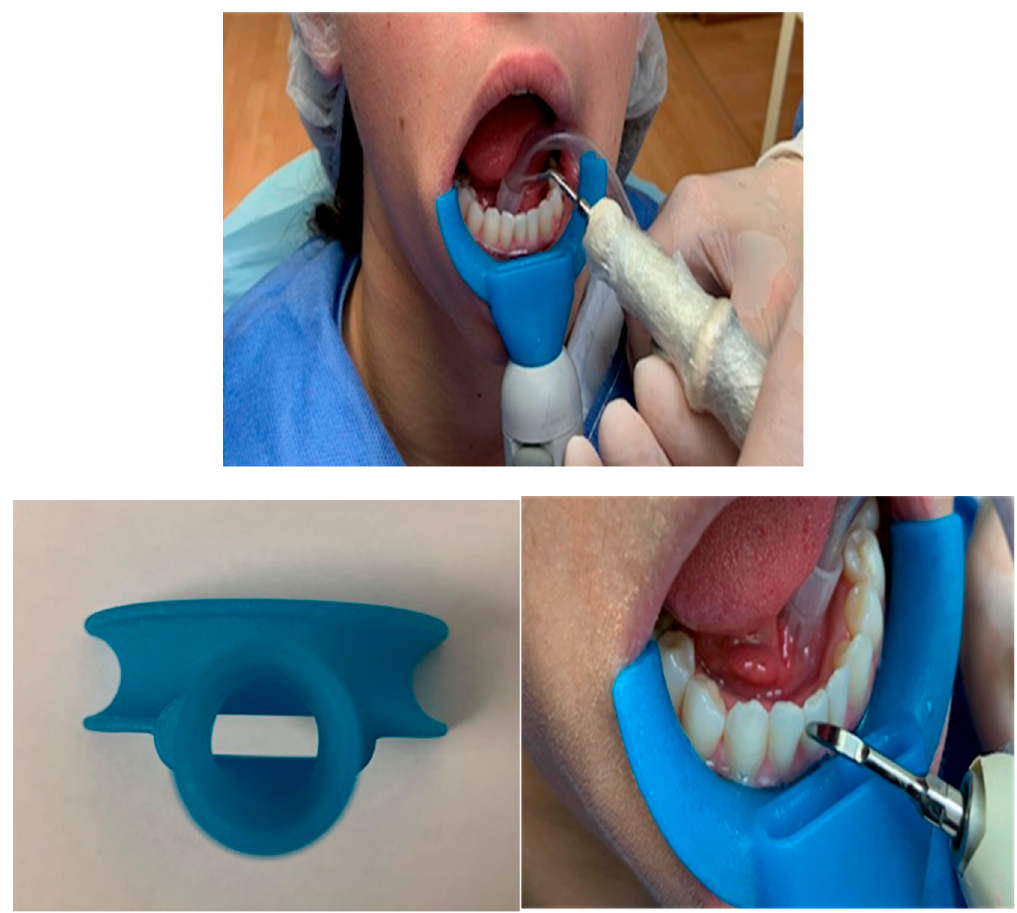
Figure 11. Power suction device .